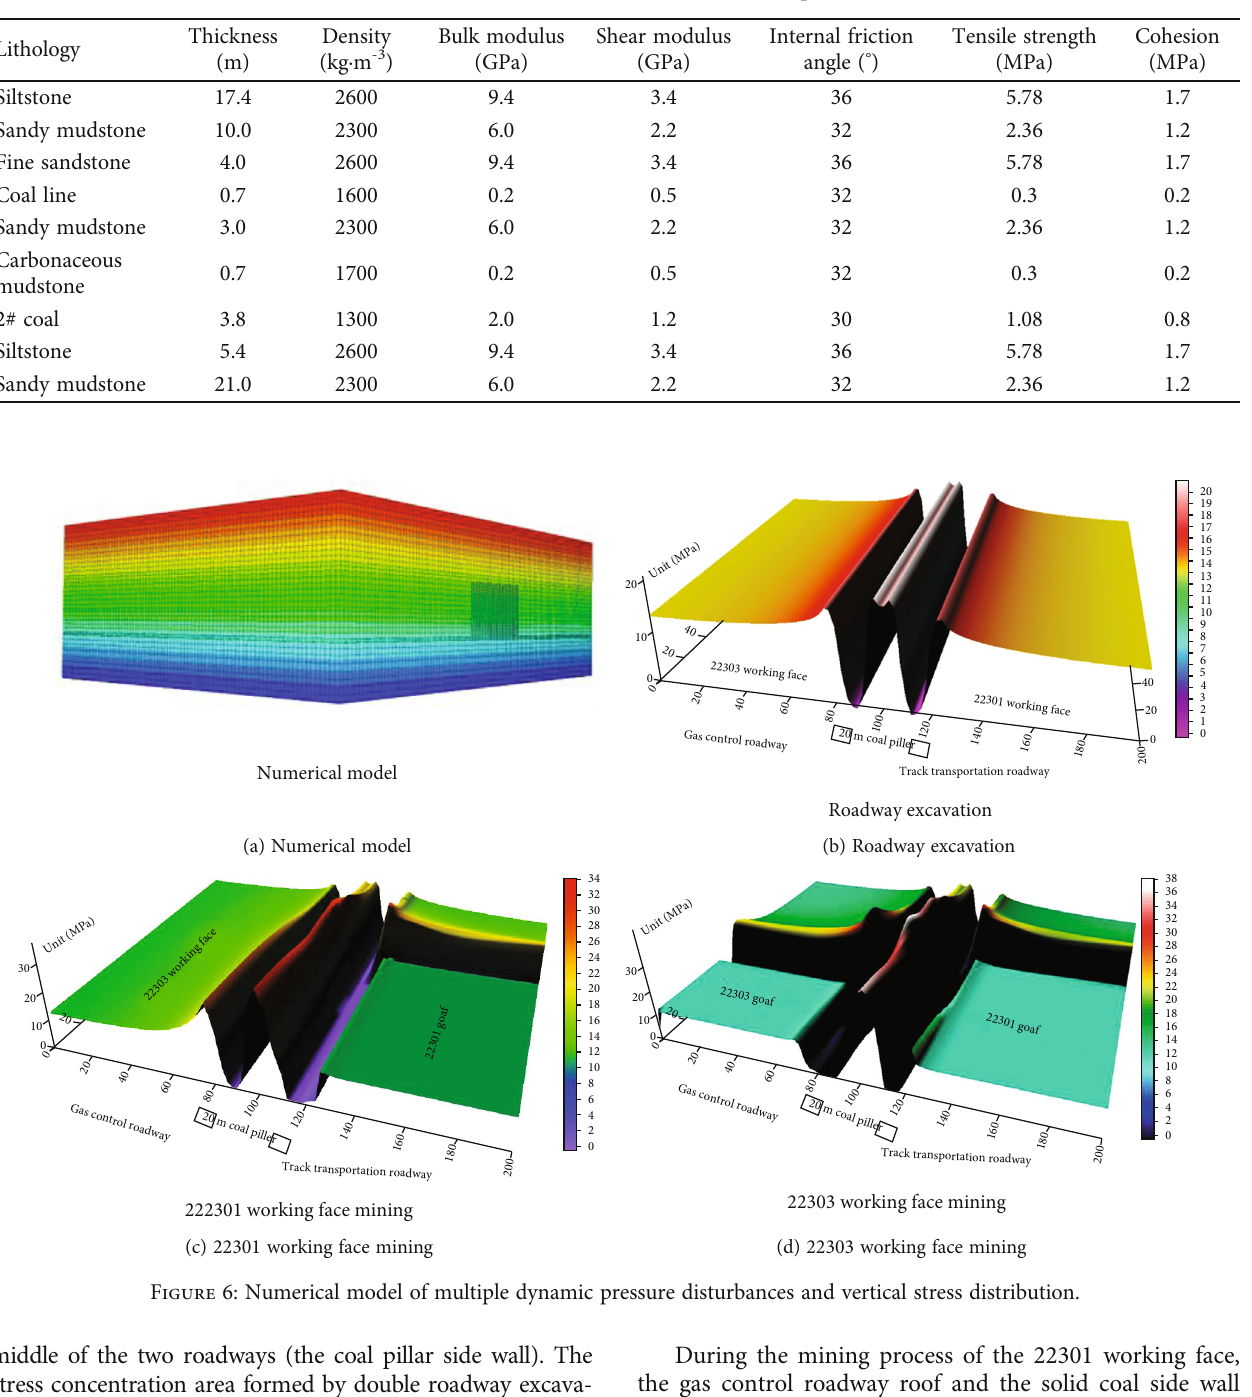
Table 1: Rock stratum distribution and mechanical